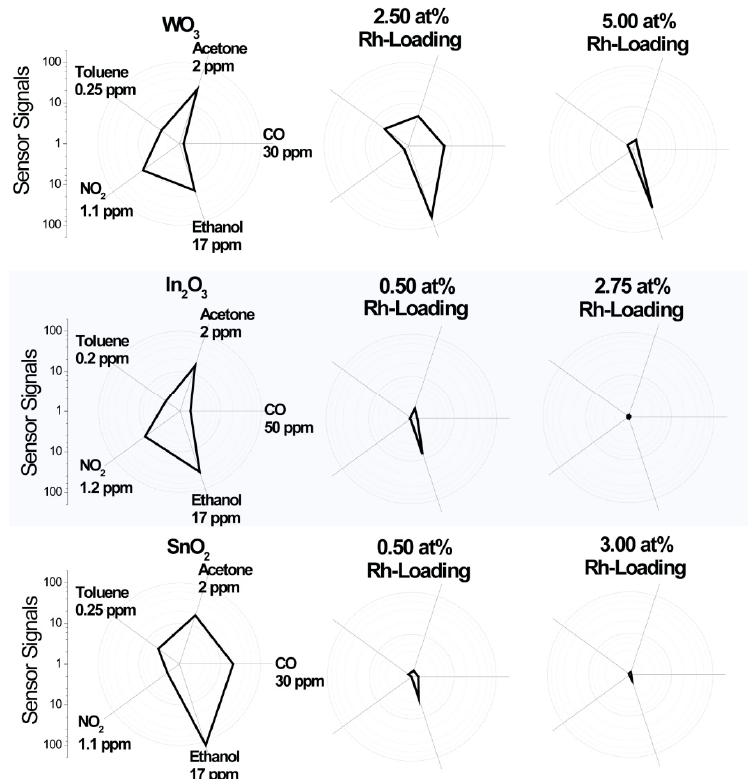
Figure 5. Signals of the sensors based on the different materials with various test gases in dry air at an operation temperature of 300 ◦ C. The results are shown in a polar plot in order to highlight the general qualities of the sensors.